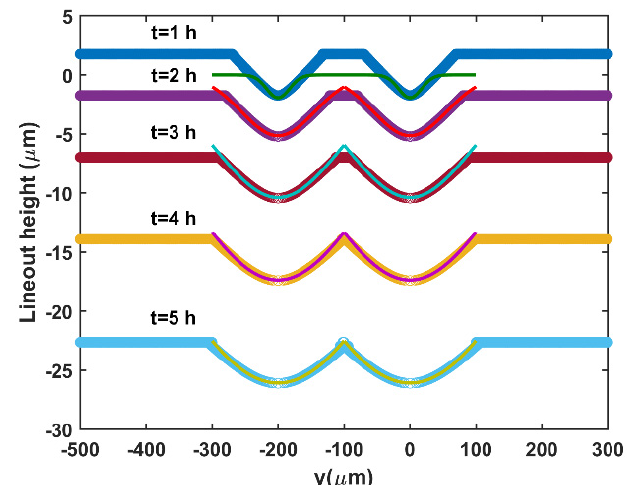
Figure 4. Surface area–volume model simulation of two neighboring parabolic cracks (thick line) and Gaussian fitting results (thin line) in 2D. The etching rate for bulk silica material was 1.74 μ m/h [34], and the etching time was 1–5 h.